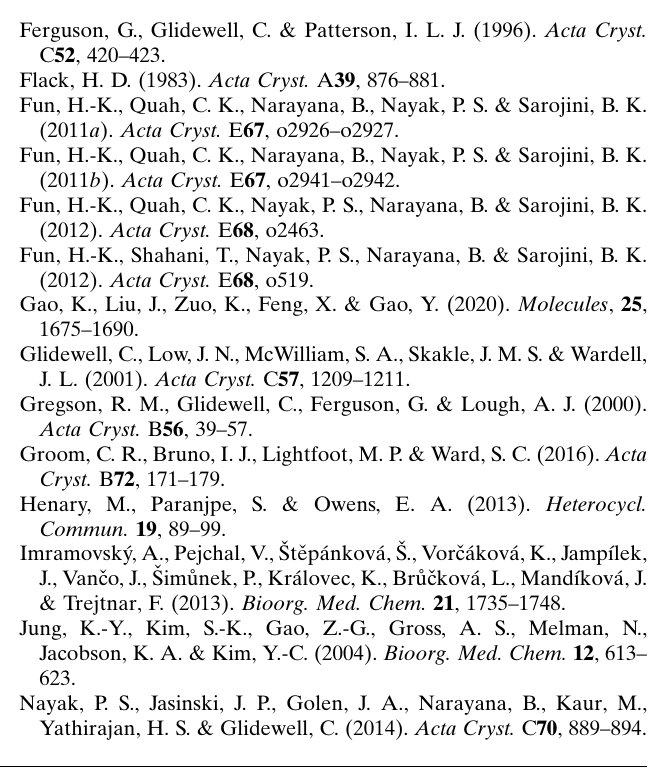
Crystal data Chemical